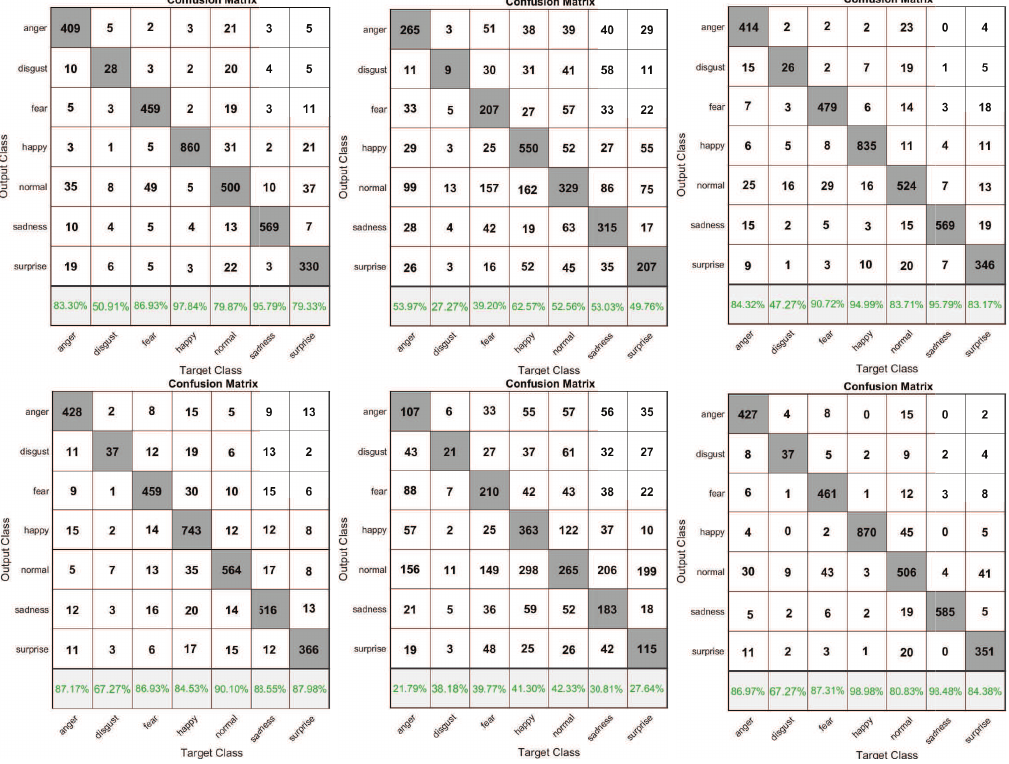
Figure 13. The confusion matrixes of the same CNN structure with six different variant activation functions for FER2013 database. From left to right, the corresponding activation functions are: sigmoid, tanh, ReLu, leaky ReLus, softplus–ReLu, and the new activation function